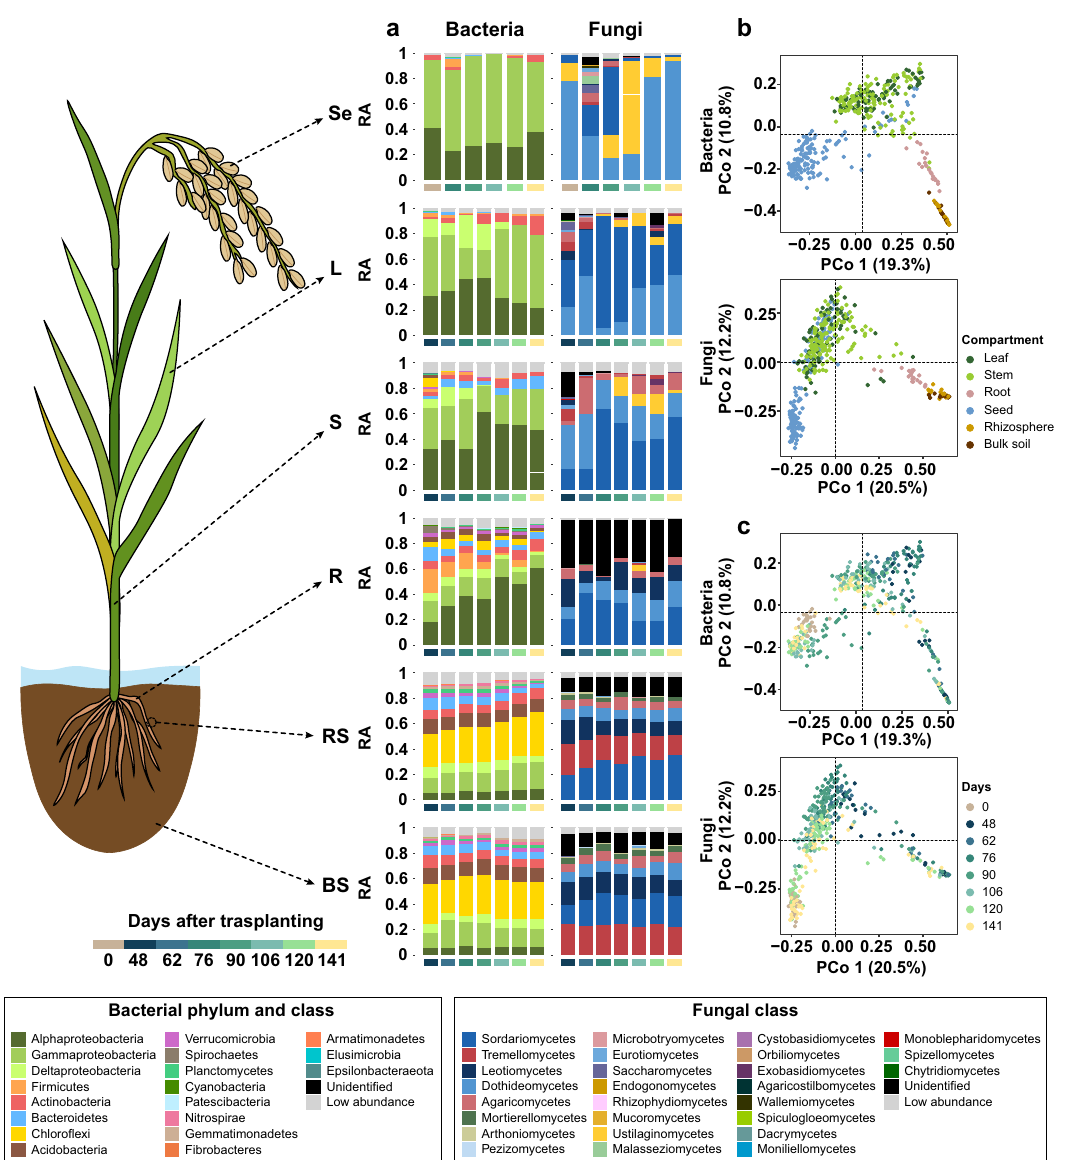
Fig. 1 Compositional variations in rice-associated bacterial and fungal communities over time. a Distribution of relative abundances of bacterial and fungal communities in different compartments during the growing season of rice. In seeds, each bar corresponds to the mean relative abundance of 27 biological replicates of each age (days after transplanting) except seeds collected at 76 days after transplanting (18 biological replicates). In other compartments, each bar represents the mean relative abundance of 9 replicates (3 biological replicates× 3 technical replicates) of a particular age. Details on replicates are available in Methods. The relative abundances of each replicate of a particular age are available in source data in the Supplementary Data 1 and Supplementary Figs. 2, 3 in the Supplementary Information. The bars are ordered by the rice age as indicated by the colored bars under each bar. BS, bulk soil; RS, rhizosphere soil; R, root endosphere; S, stem endosphere; L, leaf endosphere; Se, seeds; RA, relative abundance. b Compositional variations of bacterial and fungal communities in 2018 samples. Compositional variations among samples were estimated via principal coordinates analysis (PCoA) based on Bray-Curtis distance metric. Bray-Curtis distance was calculated from the mean abundance tables of technical replicates. The samples are colored by compartments. c The same plot of bacterial and fungal communities colored by days after transplanting. Dots represent biological replicates of each rice compartment-associated bacterial or fungal In the bulk soils and rhizosphere, Chloro fl exi (class Anaerolineae, whereas Tremellomycetes (order Cysto fi lobasidiales, 11.9 – 19.5%), 21.5 – 26.9%; order Anaerolineales, 11.7 – 14.9%) was dominant Agaricomycetes (order Agaricales, 2.3 – 5.7%), Sordariomycetes compared to plant endosphere (Fig. 1a; Supplementary Fig. 2; (order Sordariales, 9.3 – 27.2%), and Leotiomycetes (orders Helo- Supplementary Data 1). This compositional difference was also tiales, 6.1 – 12.2%; Thelebolales, 3.6 – 8.8%) dominated the rhizo- found in the fungal community. In the plant endosphere, Sordar- sphere and bulk soil fungal communities (Fig. 1a; Supplementary iomycetes (orders Hypocreales, 0.1 – 38.2%; Magnaporthales, Fig. 3; Supplementary Data 1). The occupancy ratio of bacterial and 0.1 – 11.9%), Dothideomycetes (order Pleosporales 8.9 – 91.6%), fungal taxa also varied with rice ages (sampling timepoints). Ustilaginomycetes (order Ustilaginales, 0.21 – 78.9%) were abun- For example, in root endosphere, relative abundance of Alpha- dant across years and locations (Fig. 1a; Supplementary Figs. 3, 4), proteobacteria increased from 18% to 60% along with the rice age